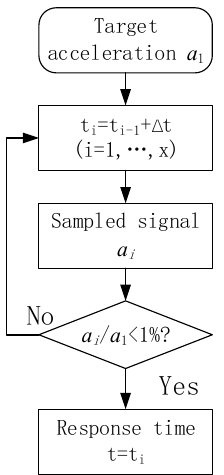
Figure 26. Logical judgment of a single response time.